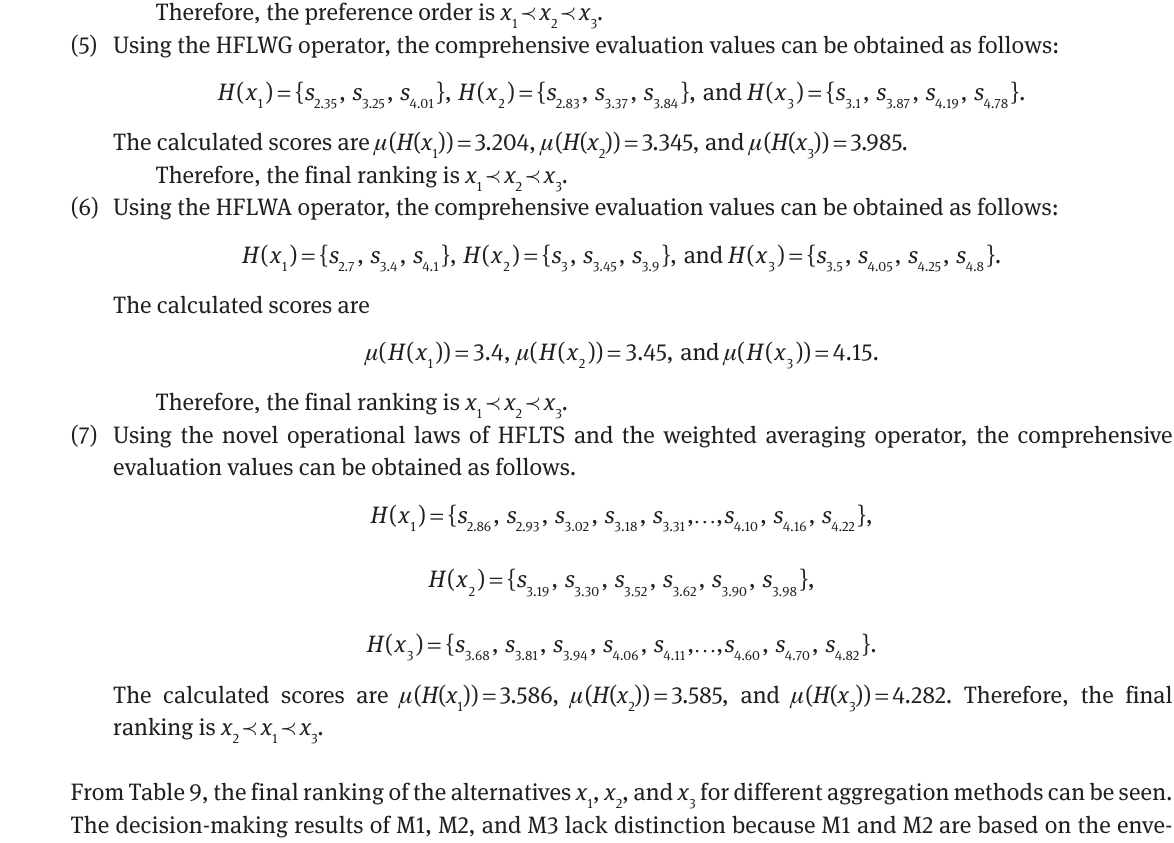
, x , and x for different aggregation methods can be seen. 1 2 3